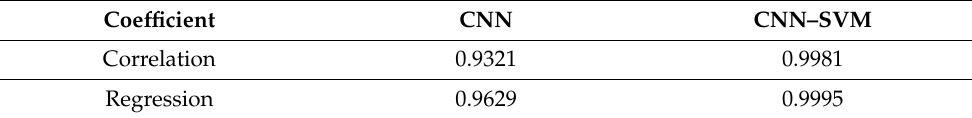
Table 5. Correlation and Regression Values of CNN and